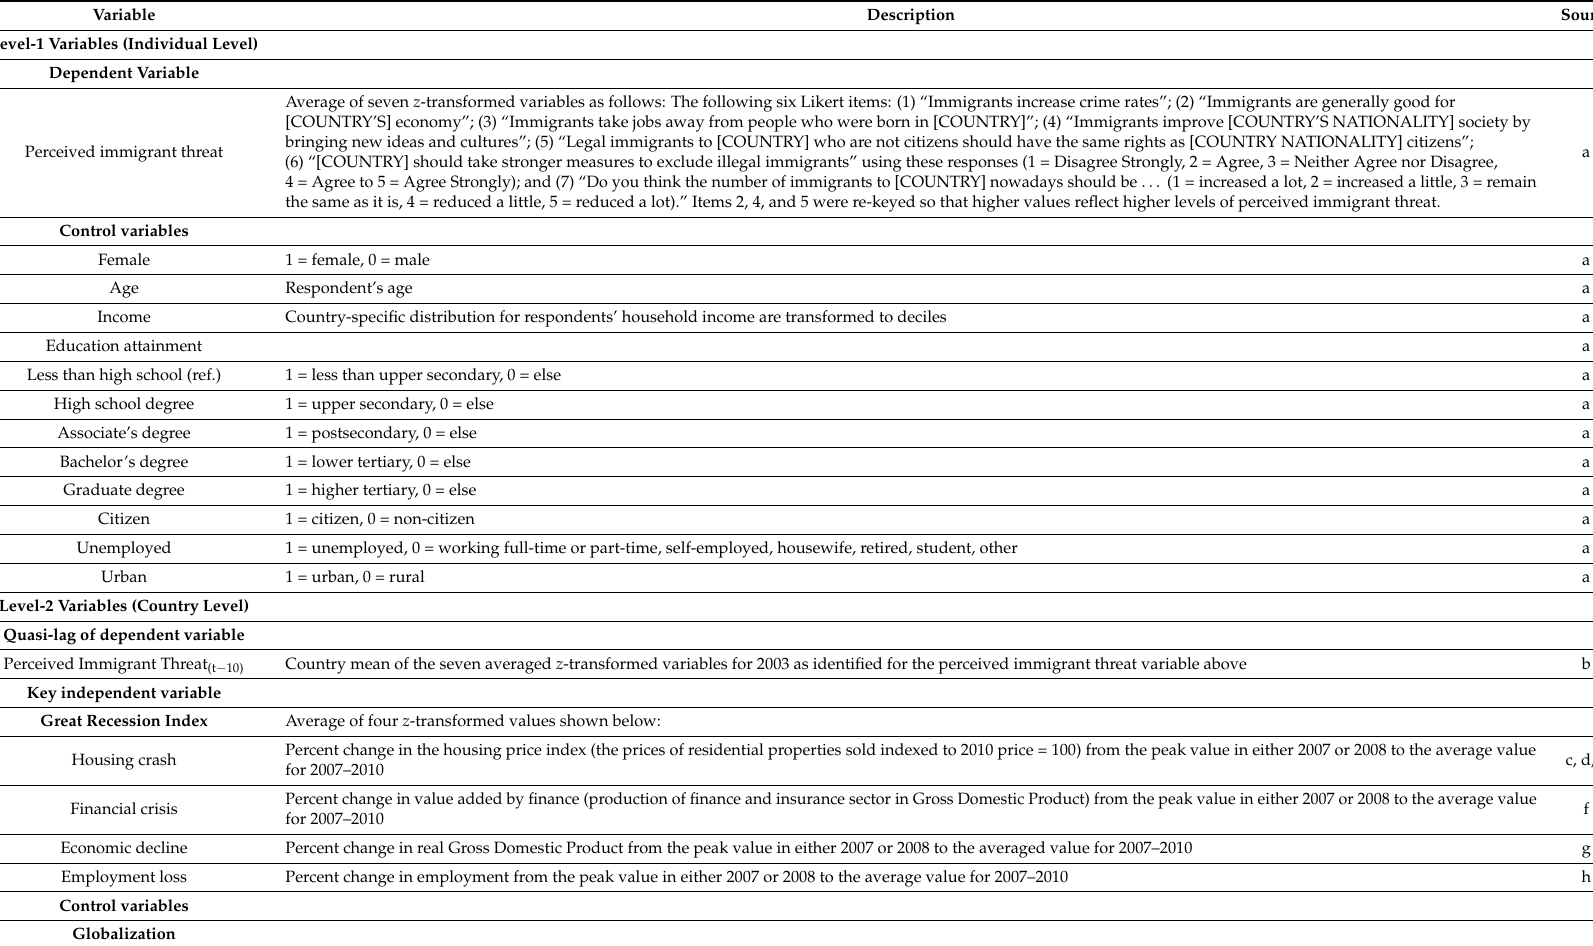
Table A1. Variables, description, and